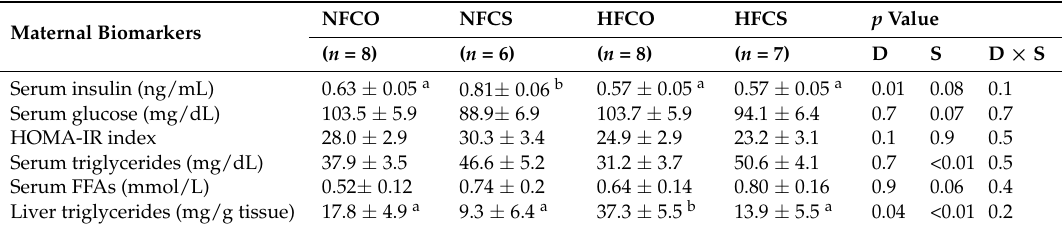
Table 2. Maternal serum and liver biomarkers at gestational day 17.5 1 . Maternal